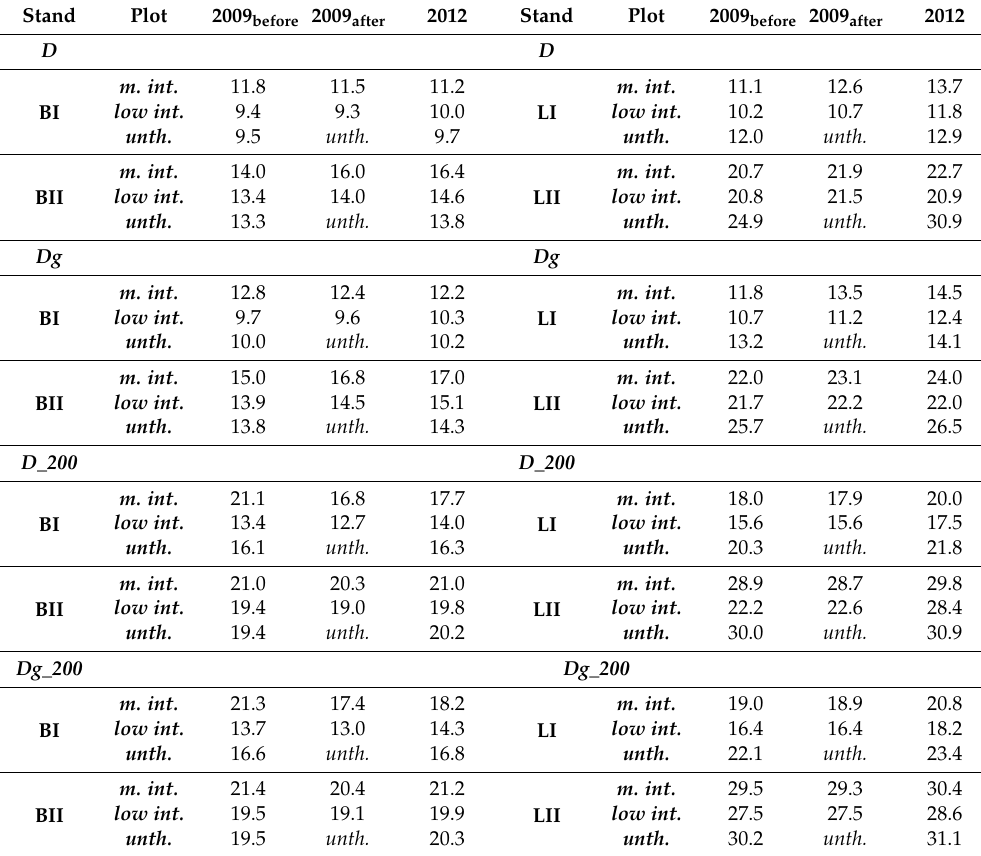
Table 4. Stand measures of the plots before (2009 before ), after the thinning (2009 after ) and at the end of the observation period in 2012. Dg: quadratic mean diameter of all trees: D: arithmetic mean diameter of all trees; Dg_200: quadratic mean diameter of the 200 strongest trees; D_200: arithmetic mean diameter of the 200 strongest trees; m. int. = medium intensity treatment; low int. = low intensity treatment; unth. = no treatment